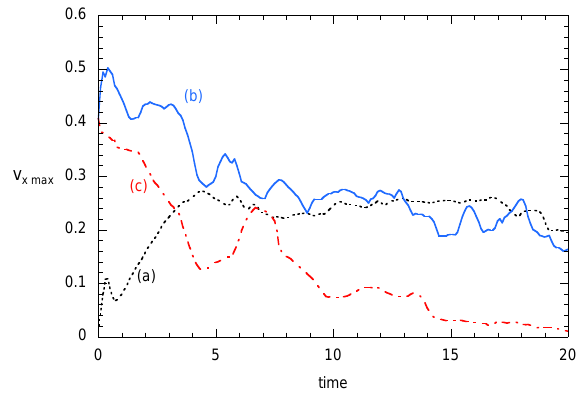
Fig. 13. Maximum earthward flow speed as a function of time for bubbles with y m = 0 . 2 and (a) pressure reduction but no ini- tial velocity (dotted line), (b) pressure reduction and initial veloc- ity (solid line), (c) no pressure reduction but finite initial velocity (dash-dotted line).